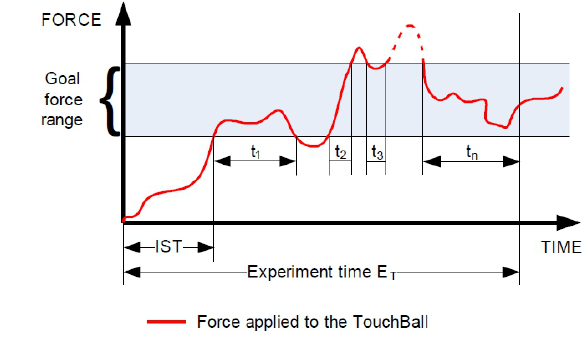
Figure 6. Changing force applied by the participant to the Touch Ball during the experiment. IST = Initial success time.